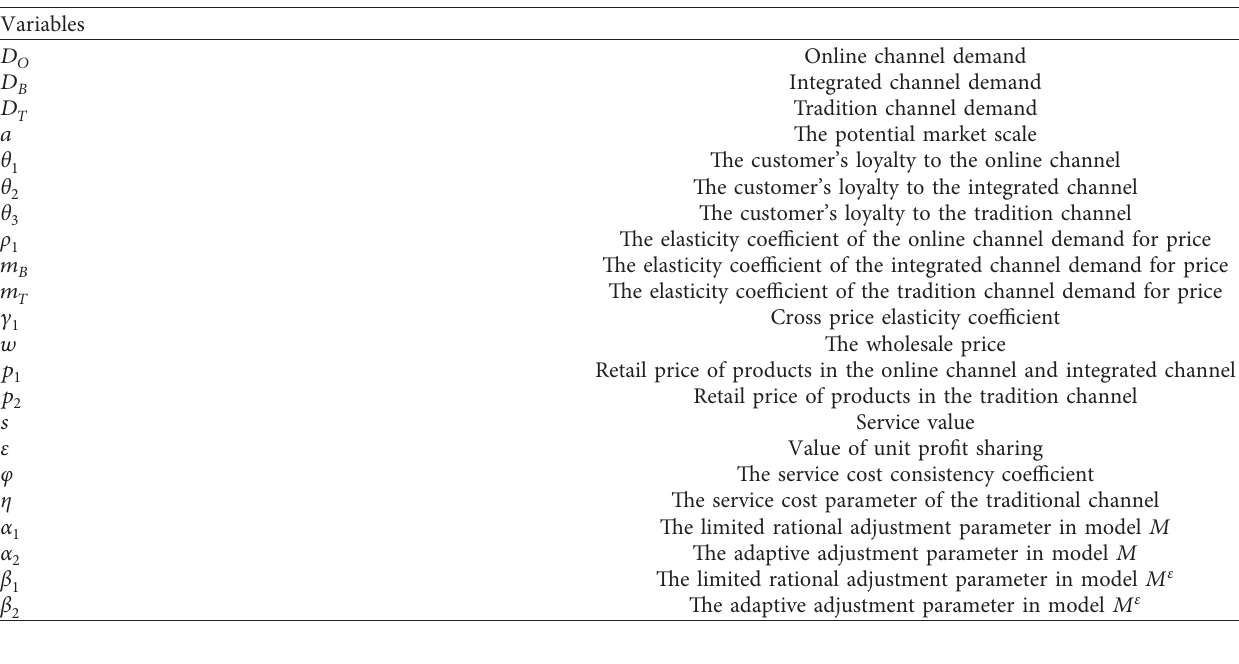
Figure 1: The supply model with the integrated Table 1: Key notations.